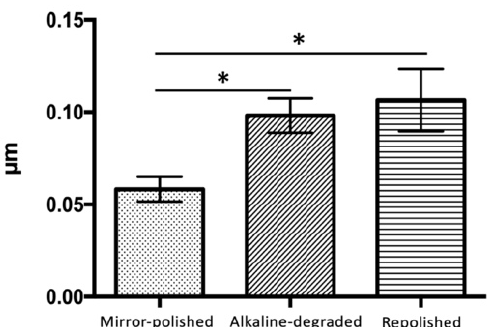
Figure 8. Line roughness. The bars (*) indicate the statistical difference (Bonferroni’s test, p < 0.001, n = 15).